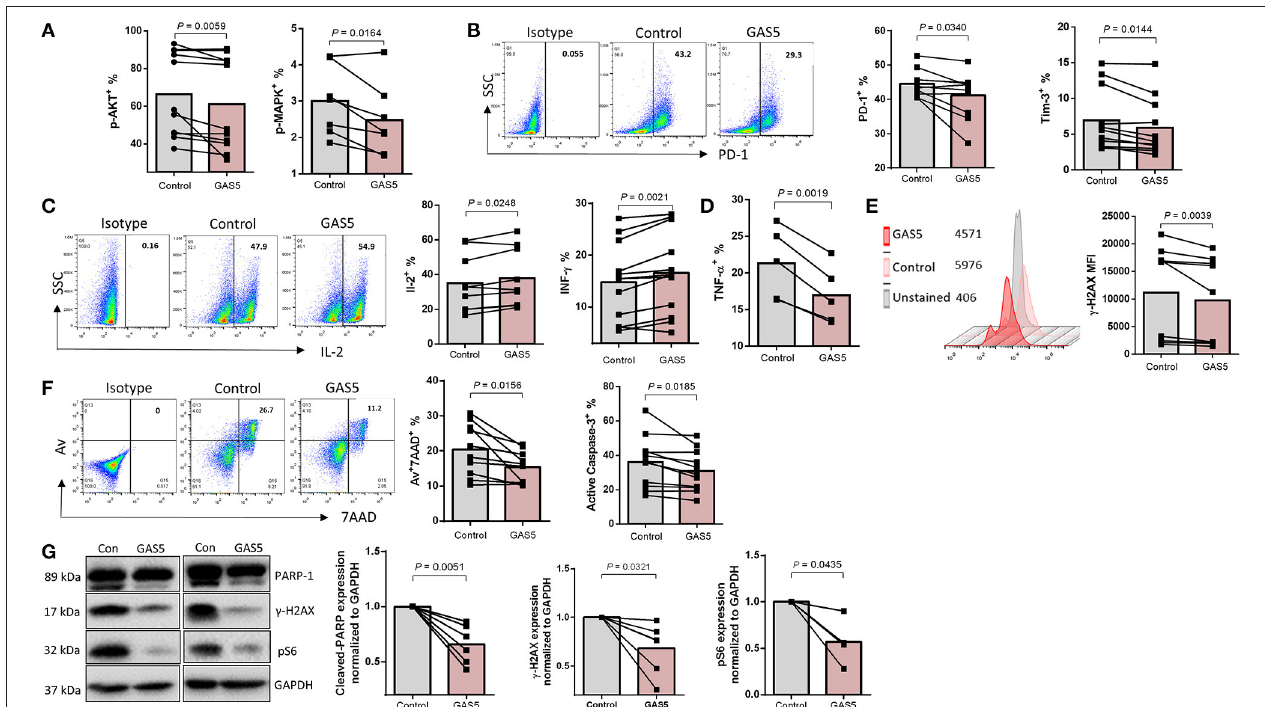
FIGURE 6 | GAS5 controls CD4T cell response and apoptosis via regulating miR-21-mediated signaling in PLHIV. (A,B) Frequencies of pAKT ( n = 11), pMAPK ( n = 7), PD-1 ( n = 10), and Tim-3 ( n = 11) in control vector or GAS5-transducted CD4T cells from PLHIV, determined by flow cytometry. (C,D) Representative dot plot and summary data of IL-2 expression ( n = 10), IFN- γ ( n = 12), and TNF- α ( n = 5), measured by flow cytometry. (E) Representative histogram and summary data of γ H2AX expression ( n = 9). (F) Representative dot plot and summary data of Av + 7AAD + CD4T cells ( n = 10) and active caspase-3 ( n = 11). (G) Representative western blot imaging and summary data of cleaved PARP-1 ( n = 6), pS6 ( n = 4), and γ H2AX ( n = 6) expressions, normalized to GAPDH.